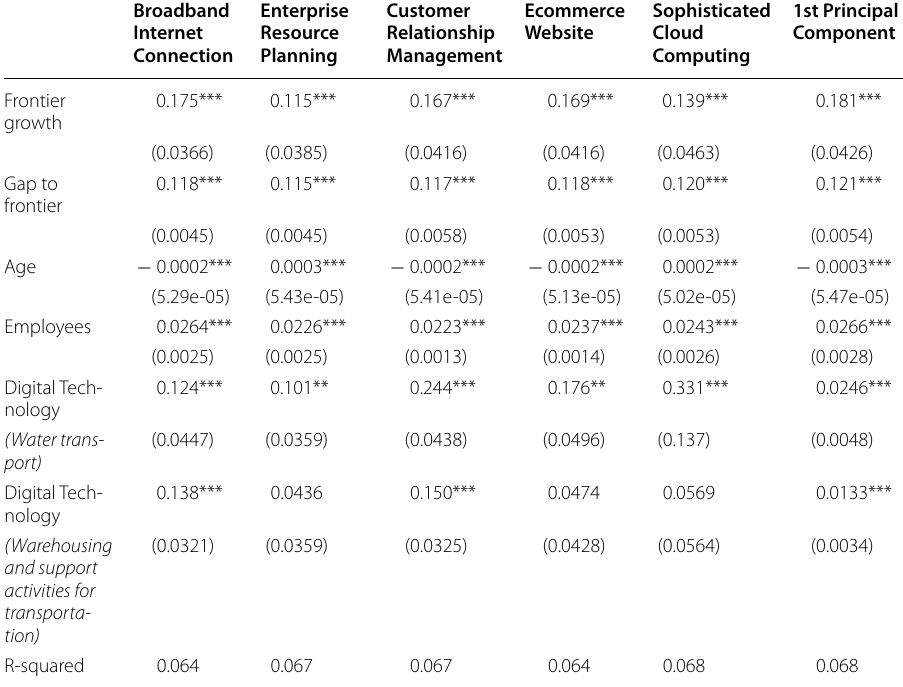
Table 5 Observing the segregation between “Water transport” & “Warehousing and support activities for transportation”